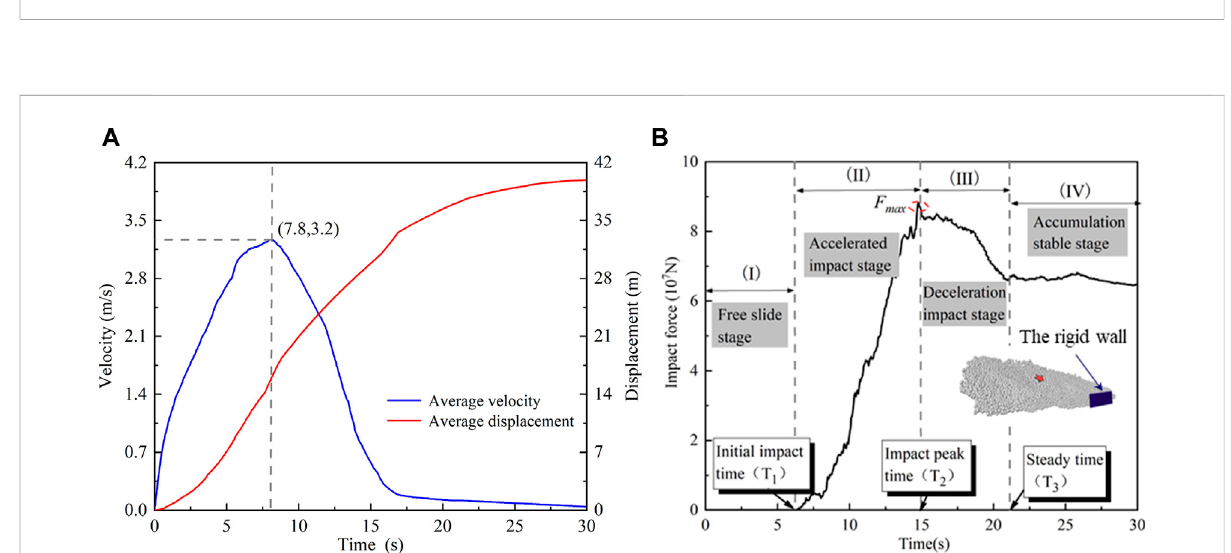
FIGURE 11 Time history curves of landslide dynamic characteristics: (A) velocity and displacement curves; (B) impact force curve.